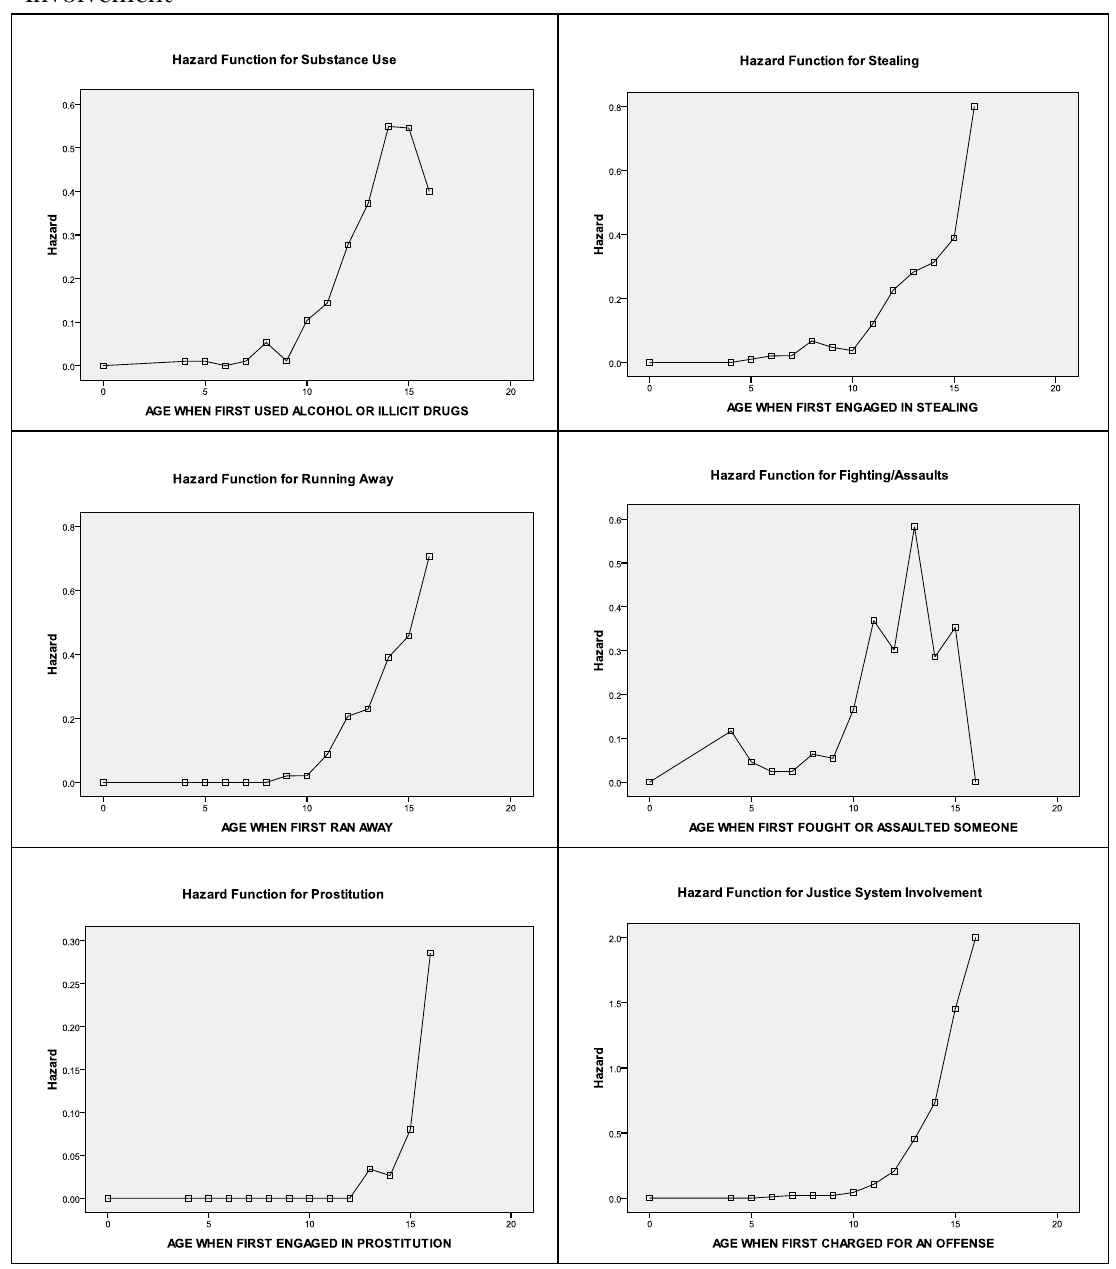
Table 9: Interpolated Hazard for Self-Reported Delinquency & Recorded SCDJJ